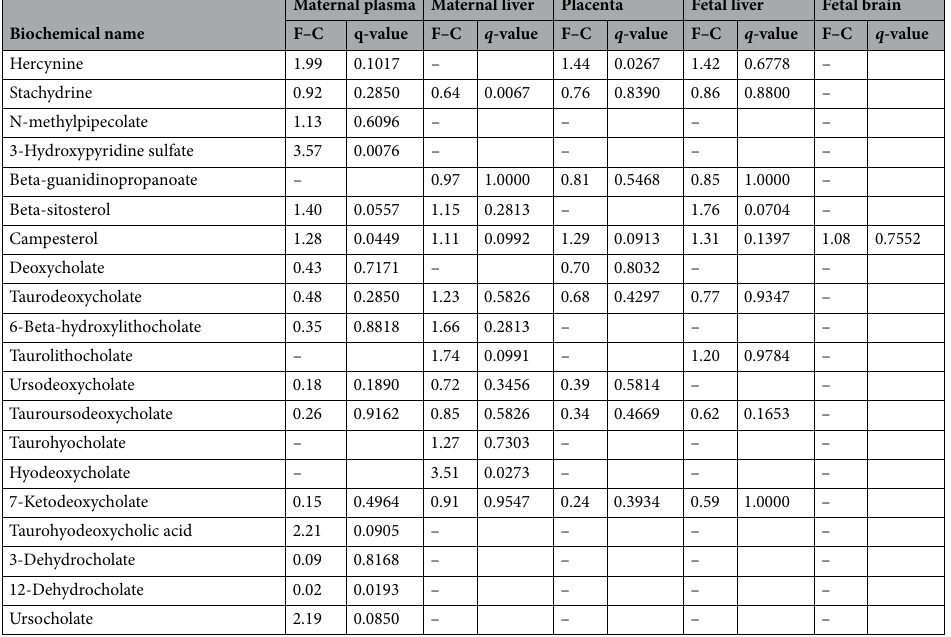
Table 4. Comparison of MDP profiles and their abundance in maternal plasma and liver, placenta, and fetal liver and brain. F–C, fold change; q -value by Mann–Whitney U-test, followed by Benjamini–Hochberg FDR adjustment. “–” indicates not detected. N = 9 control and N = 8 alcohol-treated dams and their